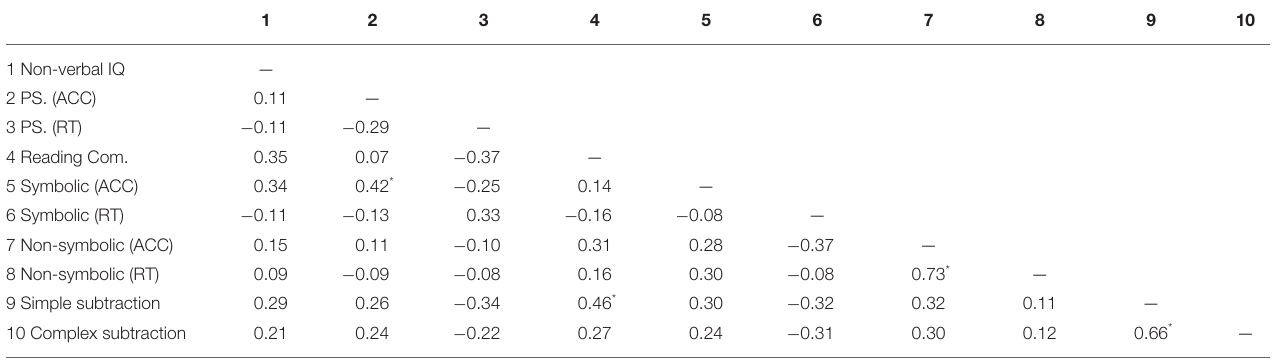
TABLE 2 | Partial correlations after controlling for age and gender differences among all the test scores in congenital group.